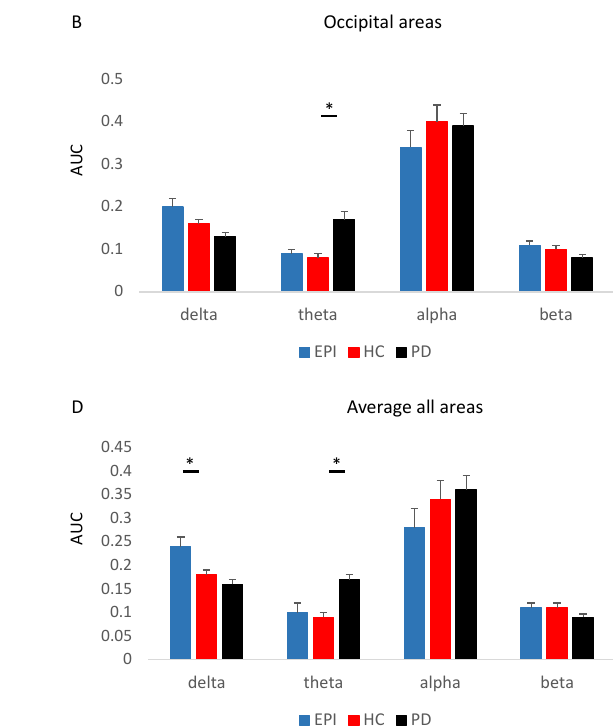
Figure 1. The average spectrum of each group in ( A ) Frontal areas, ( B ) Occipital areas, ( C ) Tempo- Parietal areas, and ( D ) an average over all areas. EPI = Epilepsy, PD = Parkinson’s disease, HC = Healthy control.